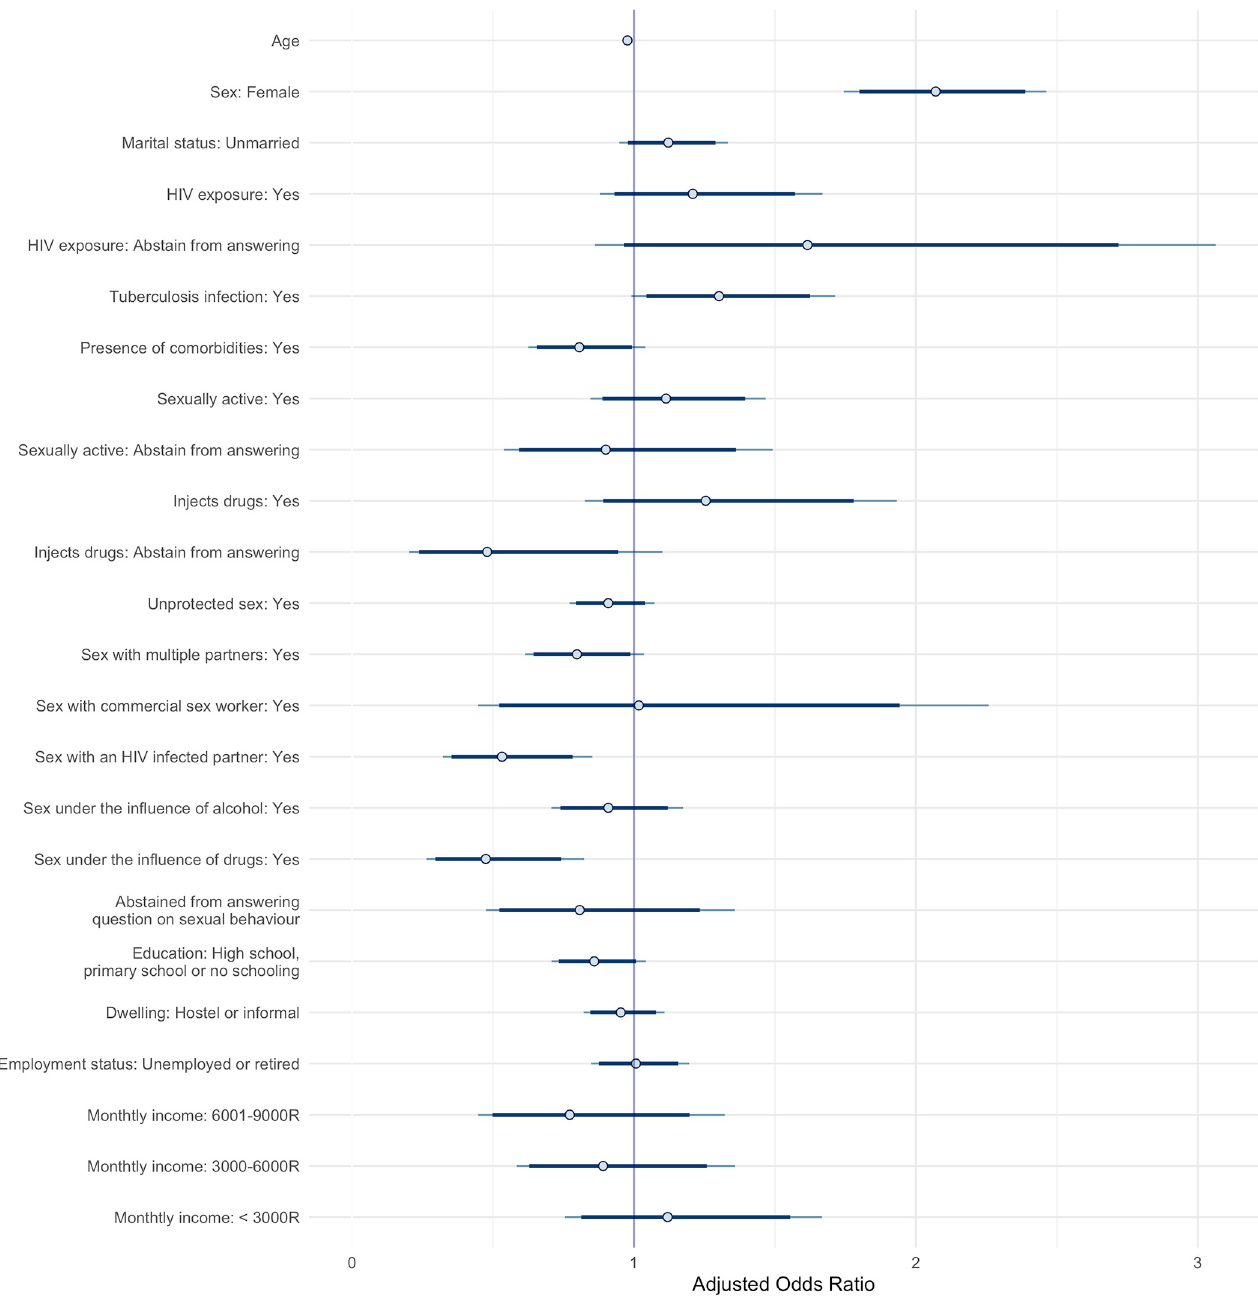
Fig 3. Bayesian logistic regression model posterior intervals of adjusted odds ratios for having tested in the past six months. Points represent the posterior medians, thick segments represent the 89% credible intervals and thin segments represent the 95% intervals of the adjusted odds ratios.